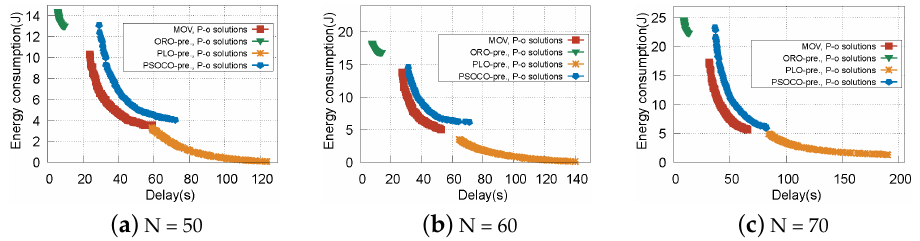
Figure 6. Pareto-optimal solutions of MOV, ORO-pre, PLO-pre, and PSOCO-pre with different numbers of vehicles.